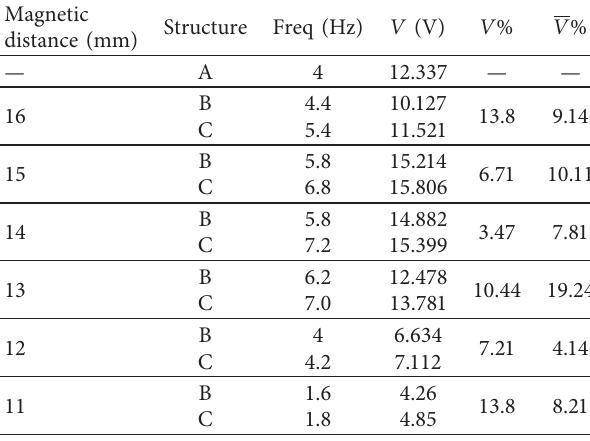
Table 1: Comparison of the power generation efficiency of the structure A, the structure B, and the structure C is given when the external excitation frequency is studied.